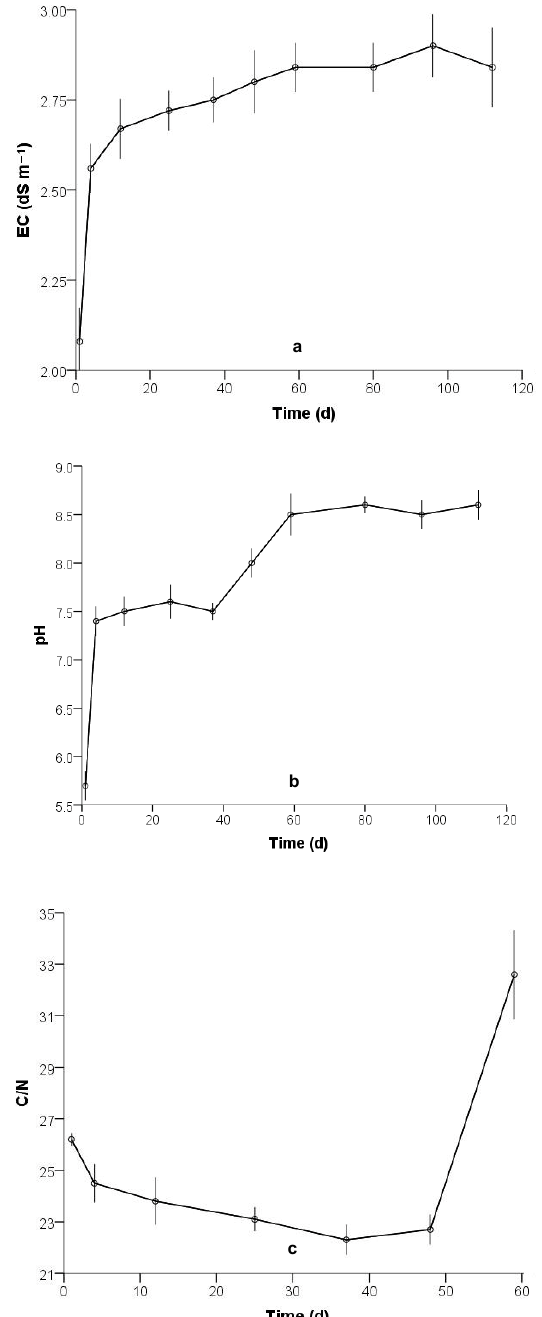
Figure 2. Time dependence of the EC ( a ), pH ( b ), and C/N ratio ( c ) values during bioremediation. Error bars were placed at the 95% confidence level.